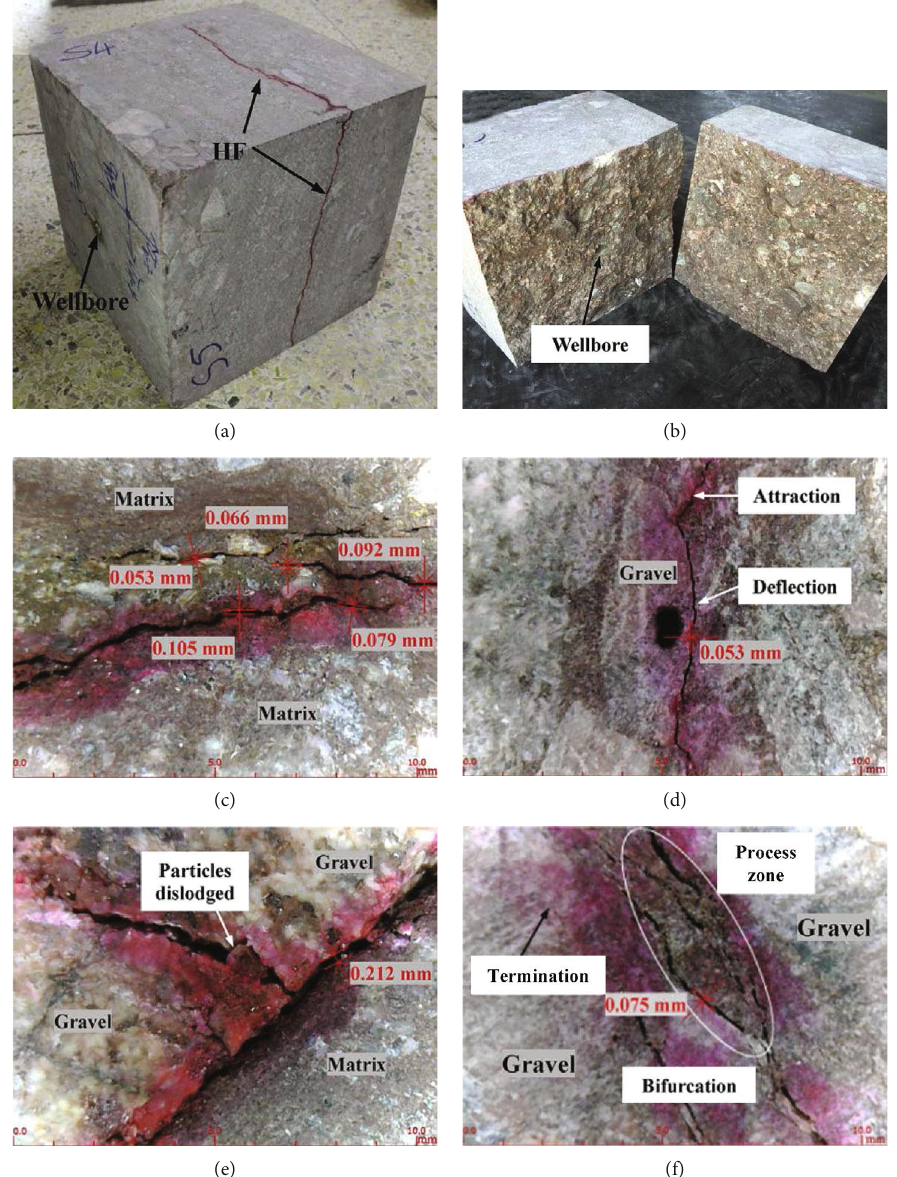
Figure 5: Physical experimental propagation morphology of HF presented by Ma et